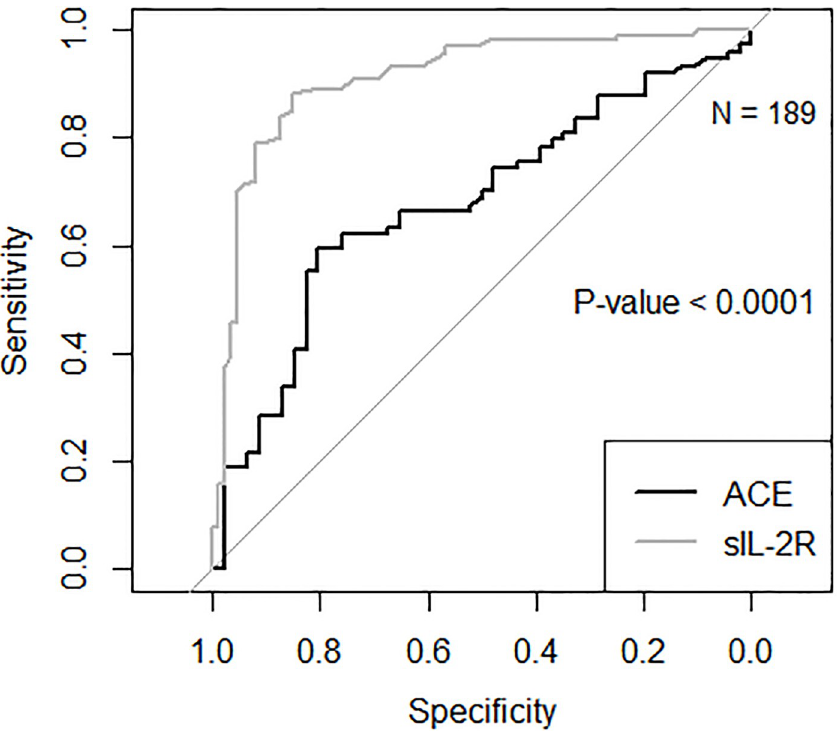
Fig 3. Receiver operating characteristic curves comparing soluble interleukin 2 receptor levels and angiotensin- converting enzyme in the diagnosis of sarcoidosis (N = 189). � sIL-2R: soluble interleukin 2 receptor. �� ACE: angiotensin-converting enzyme